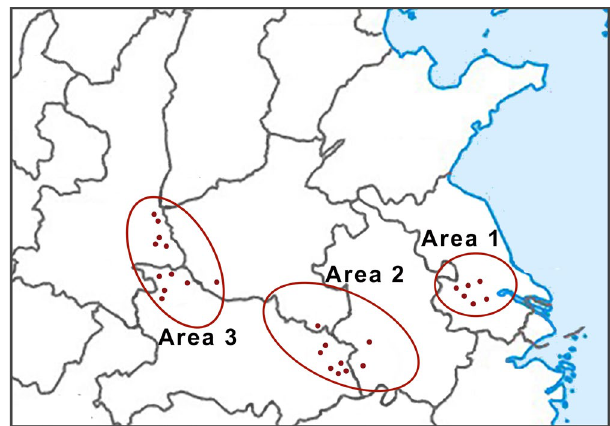
Figure 3. HCA dendrogram of 26 RAL samples from different regions using the between-groups linkage method based on squared Euclidean distance.